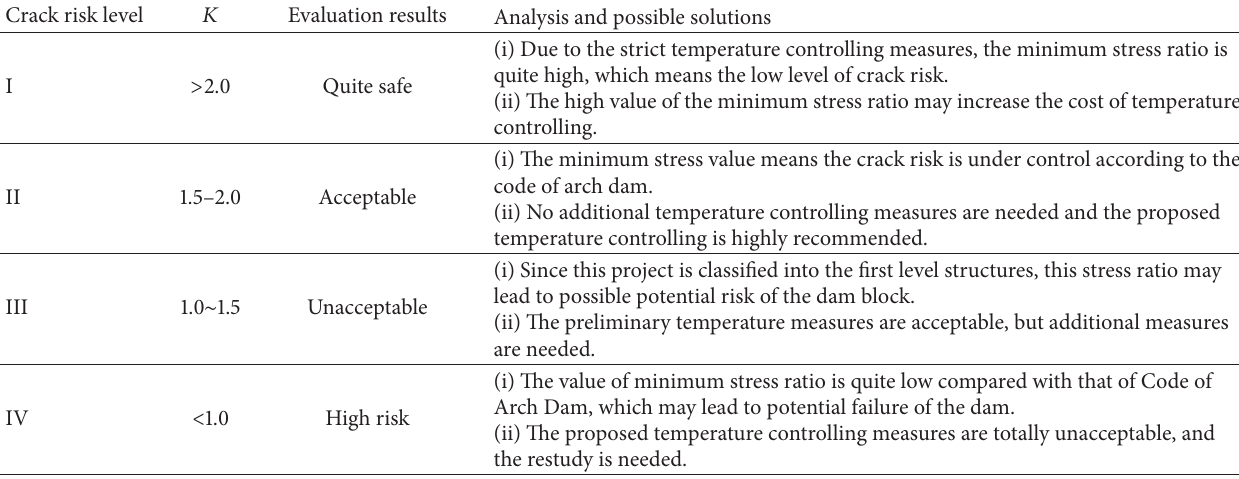
Table 1: Crack risk evaluation level under different anticrack safety factor.